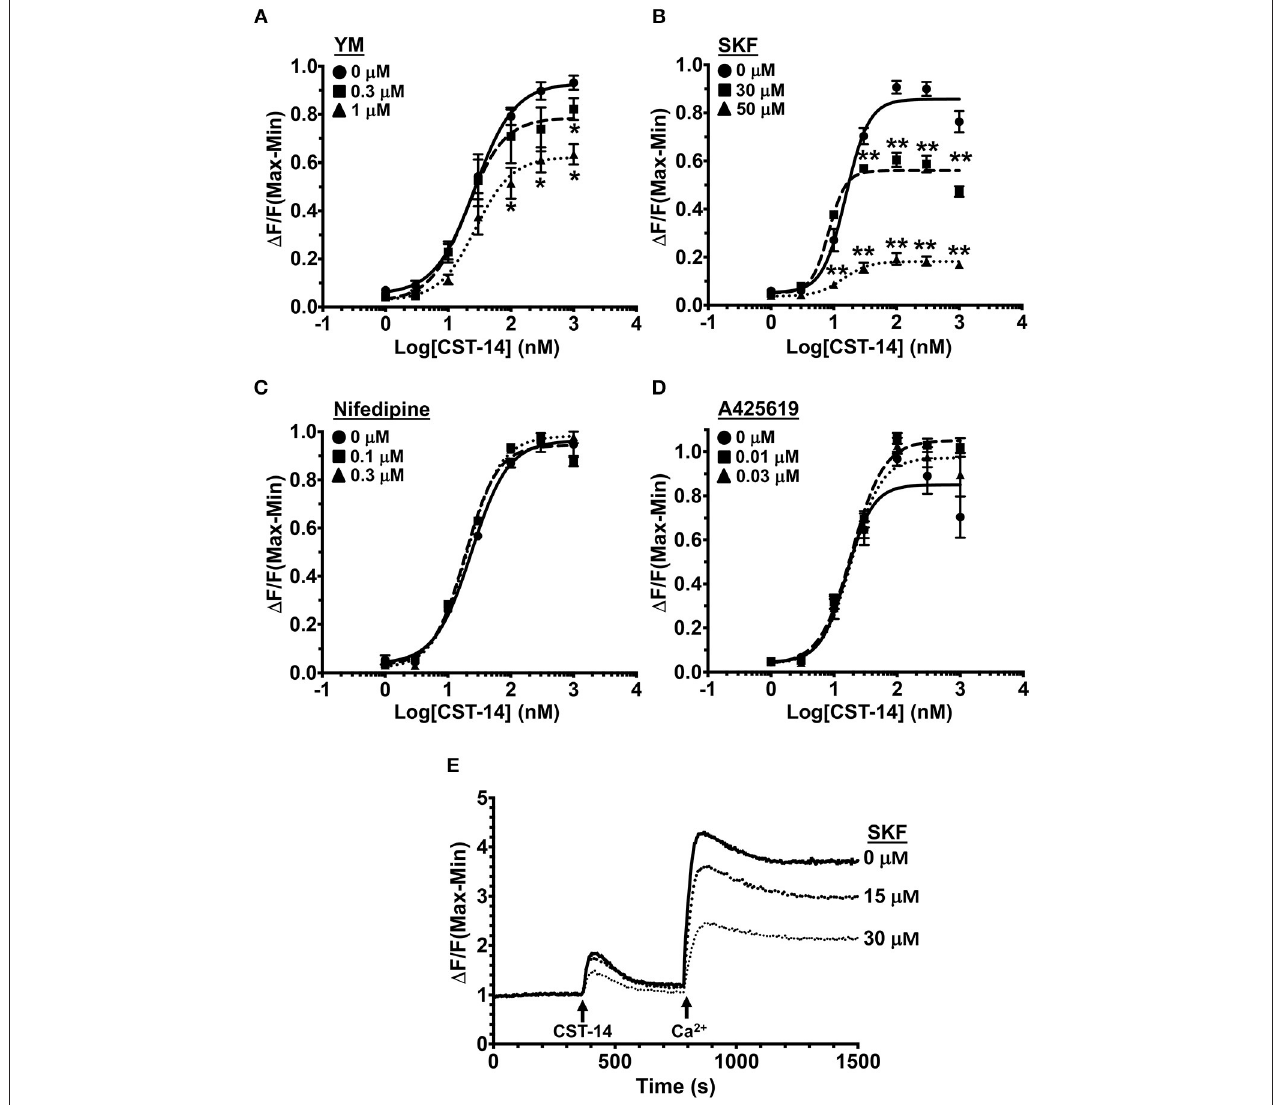
FIGURE 1 | MRGPRX2-induced Ca 2 + mobilization is reduced by SOCE inhibition. (A–D) Intracellular Ca 2 + mobilization in LAD2 human mast cells was determined following incubation with varying concentrations of (A) YM, (B) SKF, (C) Nifedipine, and (D) A425619 for 30min. Cells were treated with half log doses of the MRGPRX2 agonist cortistatin-14 (CST-14), and changes in fluorescence intensities were recorded for 120s. Data are plotted as the change in fluorescence [minimum (Min) subtracted from maximum (Max) value] normalized to the maximal change in fluorescence. (E) Traces show SOCE assay following SKF pretreatment. LAD2 cells were suspended in Ca 2 + -free buffer and stimulated with 300nM CST-14. CaCl 2 (Ca 2 + ) at a final concentration of 2mM was added to the cells at the indicated timepoint. Plotted curves are the average (mean ± S.E.) of 3–6 independent experiments. Data are analyzed with two-way ANOVA. * p < 0.05 and ** p < 0.01.